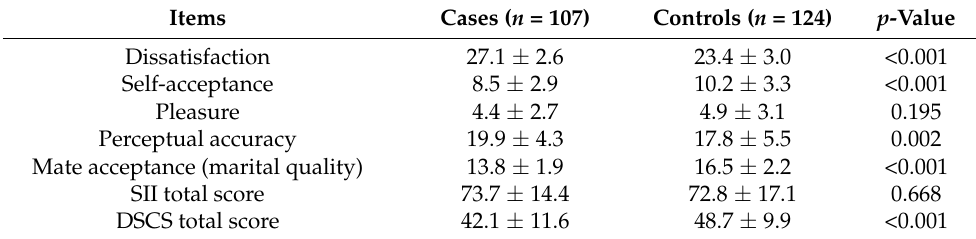
Table 5. Comparison of SII and DSCS survey results between cases and